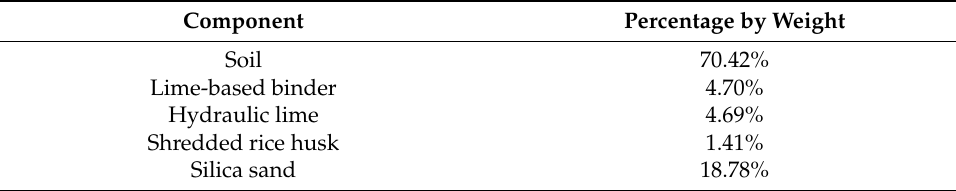
Table 1. Percentage composition by weight of the LT mix.